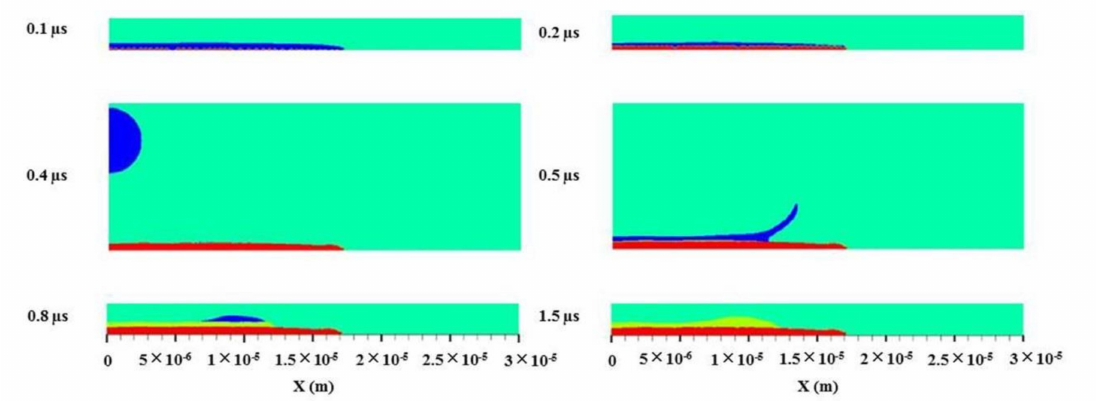
Figure 10. Flattening and solidification process of two refinement droplets at 518 m / s. (the green representing gas, the blue liquid and the red solid, respectively).